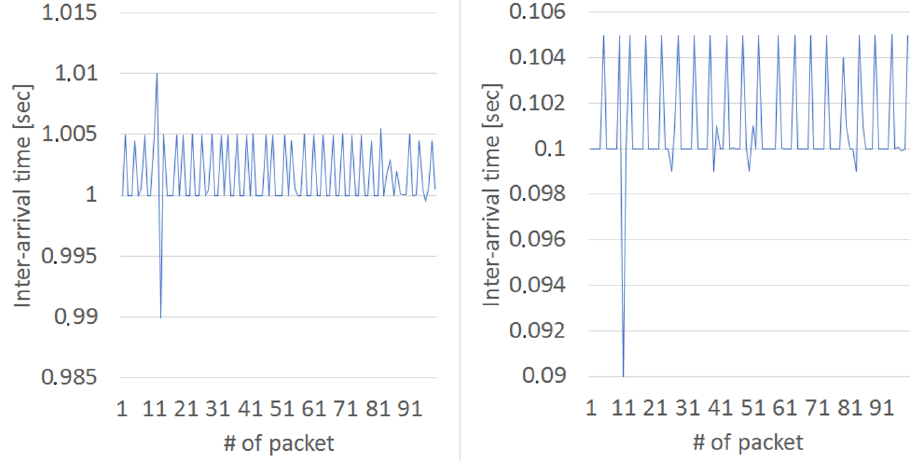
Figure 22. Jitter results ( left ): 100 Byte packets, 1000 ms sending period, ( right ): 100 Byte packets, 100 ms sending period with 50% background traffic.